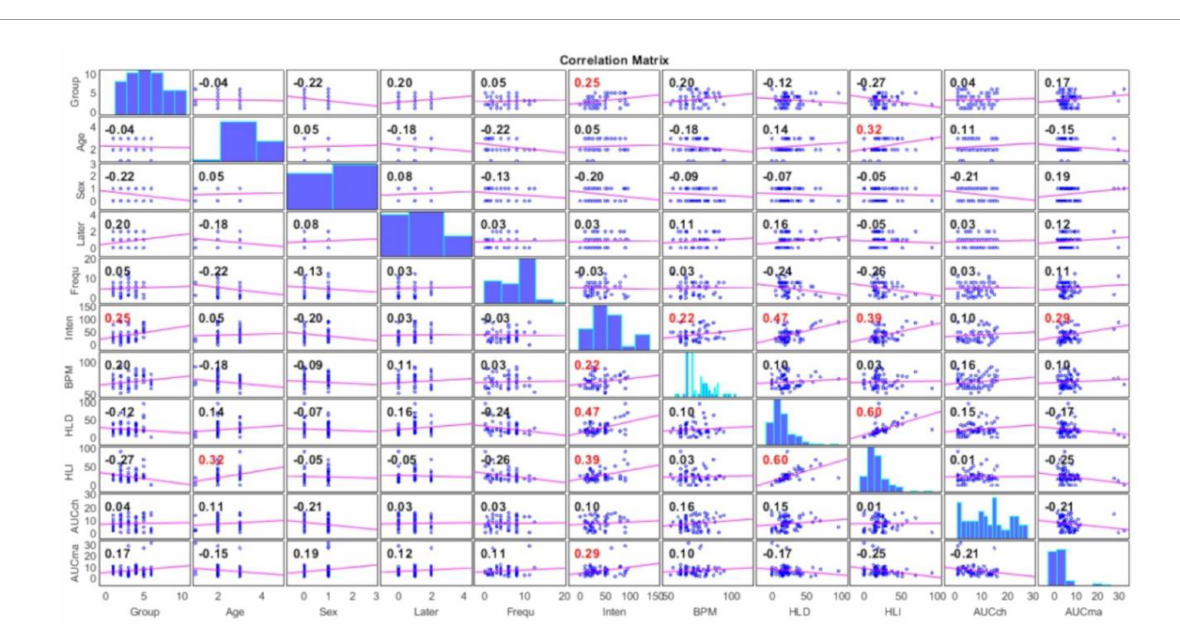
compare among different AERPs resulting from different acoustic therapies. In addition, the recording site of each AUC provides the topographical distribution of the neural